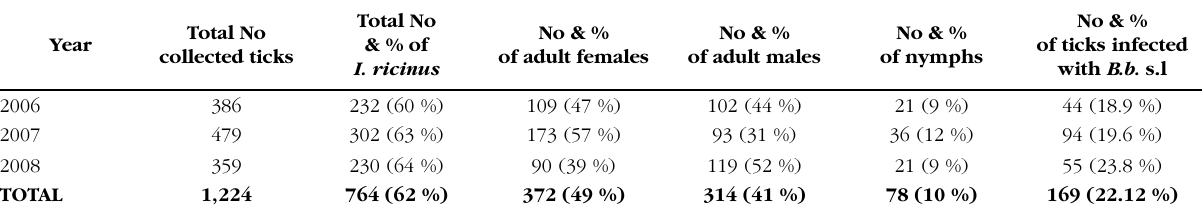
Table I. – The annual number of collected ticks infected with Borrelia burgdorferi s.l. during the period 2006-2008.